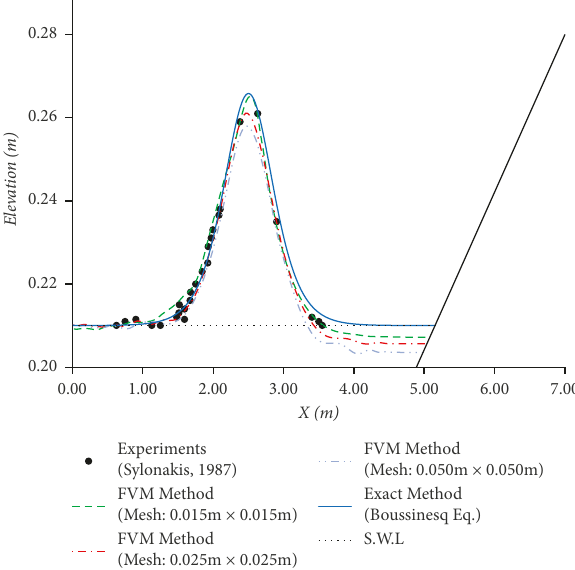
Figure 7: The simulation results of the solitary wave for different mesh sizes (before reaching the seawall).